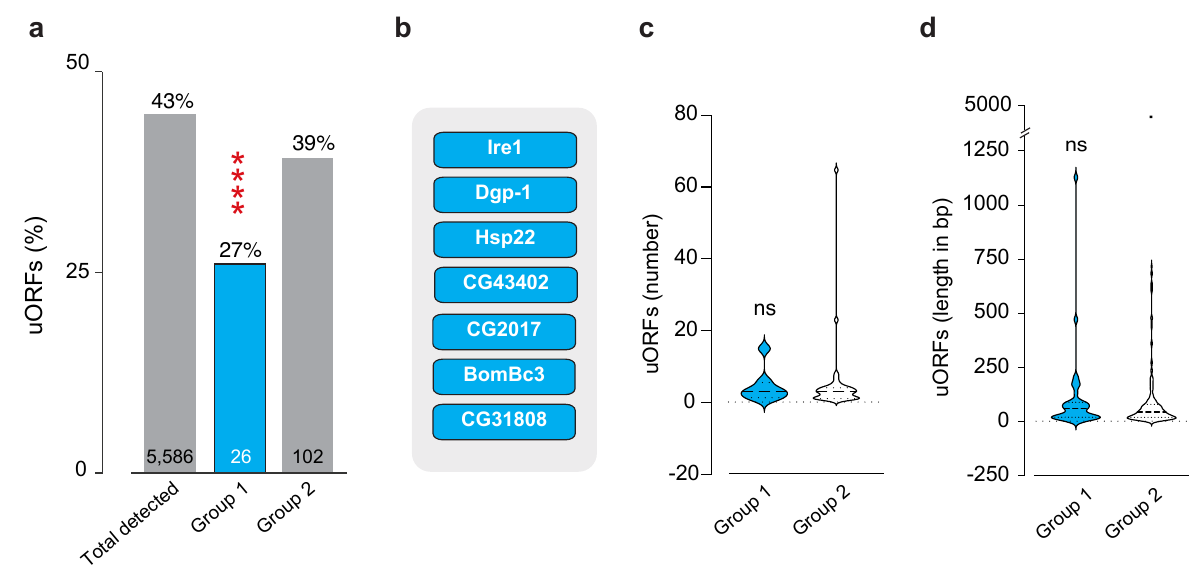
Figure 5. Analysis of upstream open reading frames (uORFs) in group 1 and group 2 genes. ( a ) Levels of uORFs, present either in the total number of molecules detected at both transcript and protein levels (total detected, Supplementary Table S16), compared to number of uORFs in group 1 or 2 (Supplementary Tables S17 and S18). Significance was calculated using a Monte Carlo test, see methods, p < 0.00001 and p = 0.10, respectively. The numbers inside the bars correspond to the total number of genes in each group. ( b ) Group 1 targets with uORFs. ( c , d ) uORF features were assessed, for respectively, ( c ), the number of uORFs per gene (median + 95% CI, Wilcoxon Rank Sum Test, p = 0.7) or ( d ), the uORF length per gene (median + 95% CI, Wilcoxon Rank Sum Test, p =